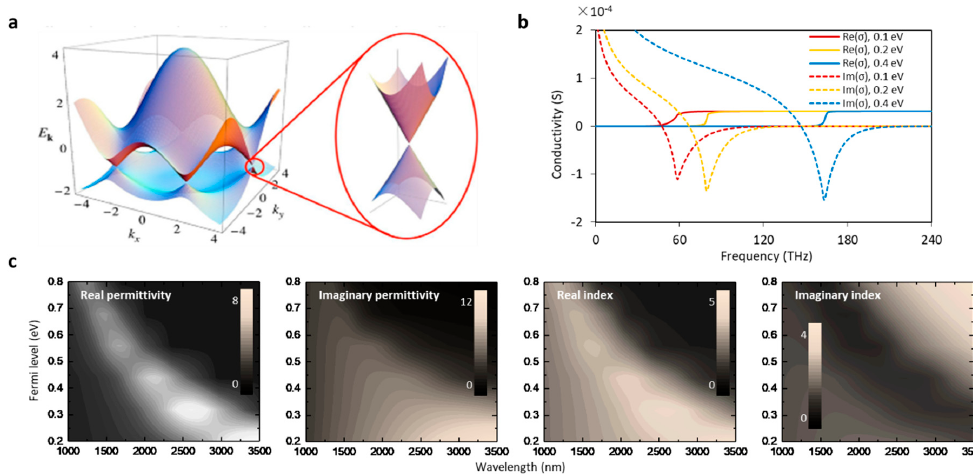
Figure 1. Optoelectronic property of graphene ( a ) Band structure; ( b ) Calculated conductivities varying in Fermi level; ( c ) Calculated permittivity and refractive index, in real and imaginary parts, respectively. Here (a,b) are reproduced from Refs. [36,42], respectively. Once incorporated with a microfiber, the graphene performs as a part of the cladding, and can influence the optical transmission via mode effective refractive index modulation. According to different graphene–microfiber hybrid geometries, the mode field distributions and complex effective index n eff can be numerically simulated or calculated via finite element method (FEM) [43,44]. Figure 2a illustrates the idea of modelling the graphene-based microfibers for effective index approximation. Figure 2b provides examples of the spatial distributions of electric field intensity (fundamental mode) for different types of graphene-based microfiber structures. Upper panels: graphene-wrapped microfiber with core diameter ≈ 0.5 µm and 1 µm [43,45], lower panels: graphene-wrapped microfiber with core diameter ≈ 8 µm while cladding thickness ≈ 2 µm [46]. The mode effective index of a hybrid waveguide is also influenced by the optoelectronic dynamics of graphene. Figure 2c plots the simulated “ n eff vs. | E F |” correlation of a graphene-based microfiber with core diameter ≈ 8 µm. It can